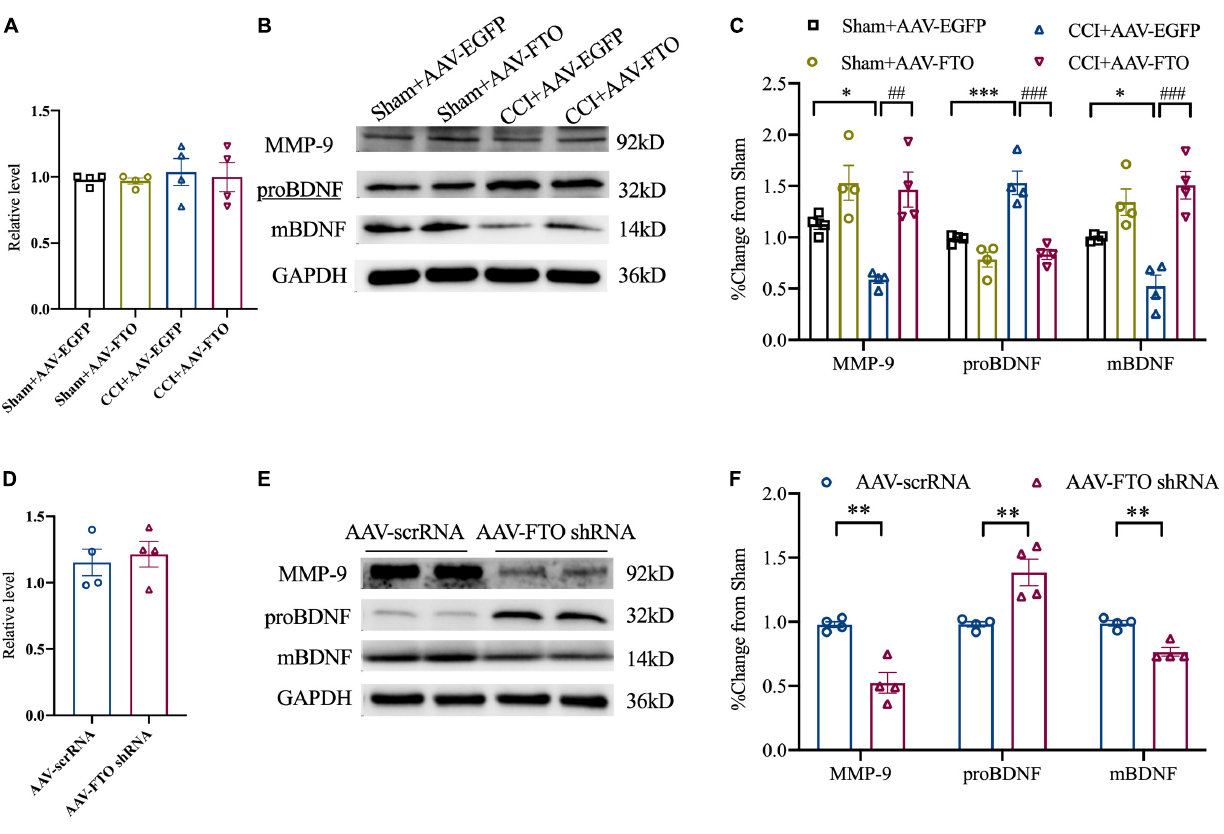
FIGURE 6 | Fat mass and obesity-related protein affects the maturation of brain-derived neurotrophic factor by regulating MMP-9. (A) The expression of MMP-9 mRNA 21 days after ACC injection of AAV in Sham and CCI mice. (B,C) The expression of MMP-9, proBDNF, and mBDNF proteins 21 days after ACC injection of AAV-FTO in the Sham group and CCI group ( *P < 0.05, ***P < 0.001 vs. Sham-AAV-EGFP, ## P < 0.01, ### P < 0.001 vs. CCI-AAV-FTO). (D) The expression of MMP-9 mRNA 21 days after ACC injection of AAV in naïve mice. (E,F) Changes in protein levels of MMP-9, proBDNF, and mBDNF in naïve mice after ACC injection of AAV for 21 days ( **P < 0.01 vs. AAV